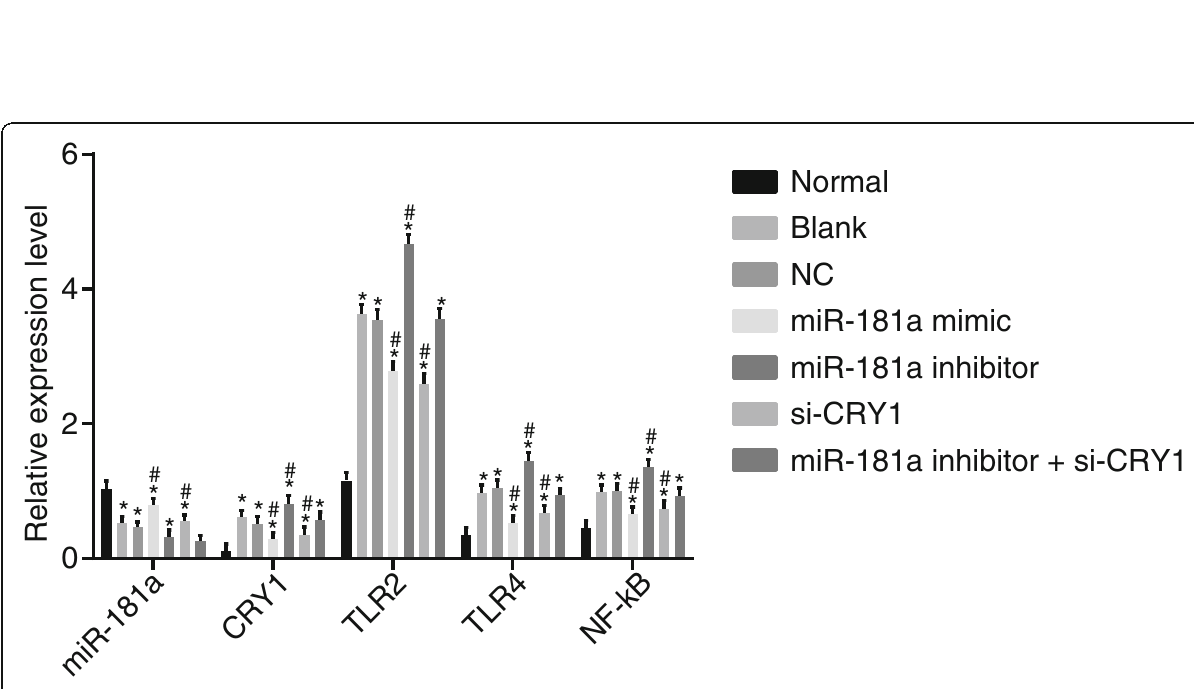
Fig. 9 RT-qPCR results demonstrate that up-regulated miR-181a or down-regulated CRY1 suppresses the activation of the TLR/NF- κ B pathway by decreasing the mRNA expression of TLR/NF- κ B pathway-related genes. Notes: * , p <0.05 vs. the normal group; # , p <0.05 vs. the blank and NC groups; the data are presented as the mean±standard deviation, analyzed by one-way ANOVA; the experiment was independently repeated three times; NC, negative control; miR-181a, microRNA-181a; CRY1, cryptochrome 1; TLR2, Toll-like receptor 2; TLR4, Toll-like receptor 4; NF- κ B, nuclear factor-kappa B; CKD, chronic kidney